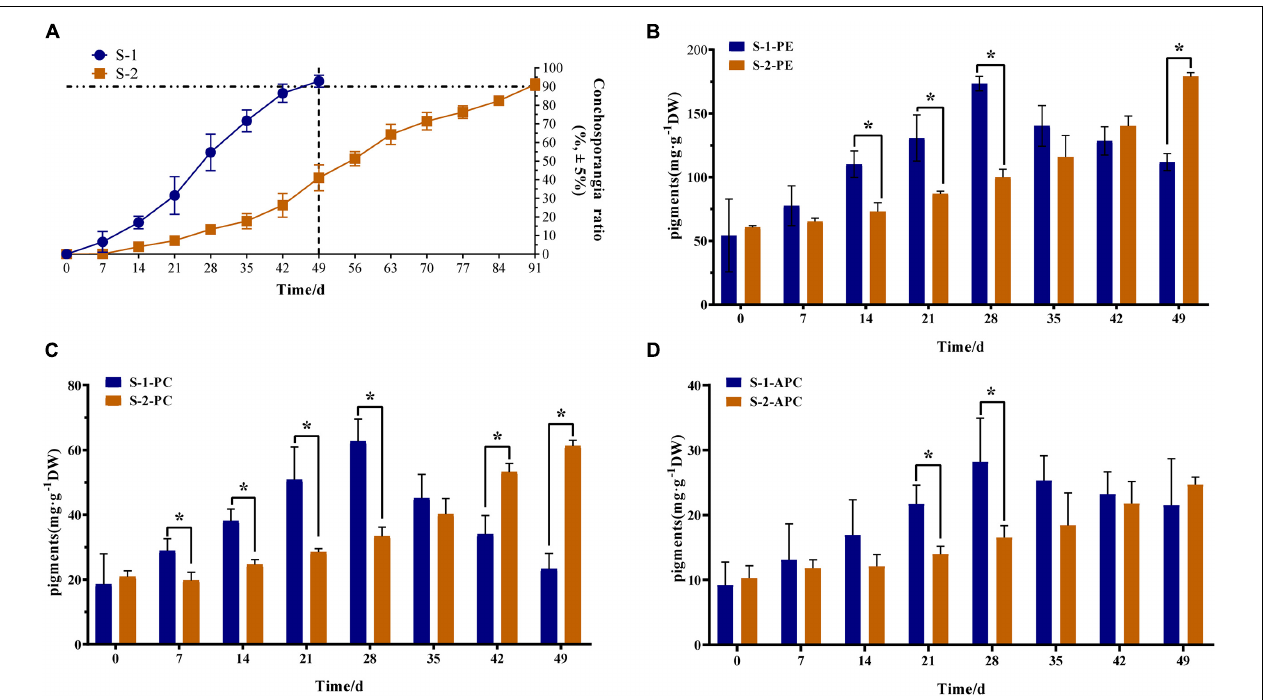
FIGURE 1 | Phenotypic and phycobiliprotein content differences between S-1 and S-2 strains of Pyropia haitanensis . (A) Ratio of conchosporangia in S-1 and S-2 strains ( n = 10). (B) Phycoerythrin (PE) content in S-1 and S-2 strain (n = 3). (C) Phycocyanin (PC) content in S-1 and S-2 strains ( n = 3). (D) Allophycocyanin (APC) content in S-1 and S-2 strains ( n = 3). Data are means ± SD. Statistical significance was calculated by Student’s t -test. Significant differences level: * P <